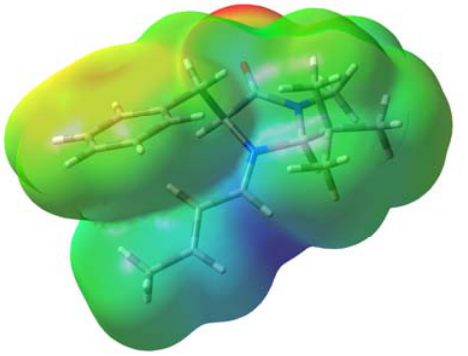
Figure 3. Electrostatic potential map for conformer 1A plotted onto an isodensity surface (0.004 e au − 3 ) obtained from the density calculated at the B3LYP/6-31G(d) level. The colour code corresponds to the charge from 0.03 (red) to 0.16 (dark